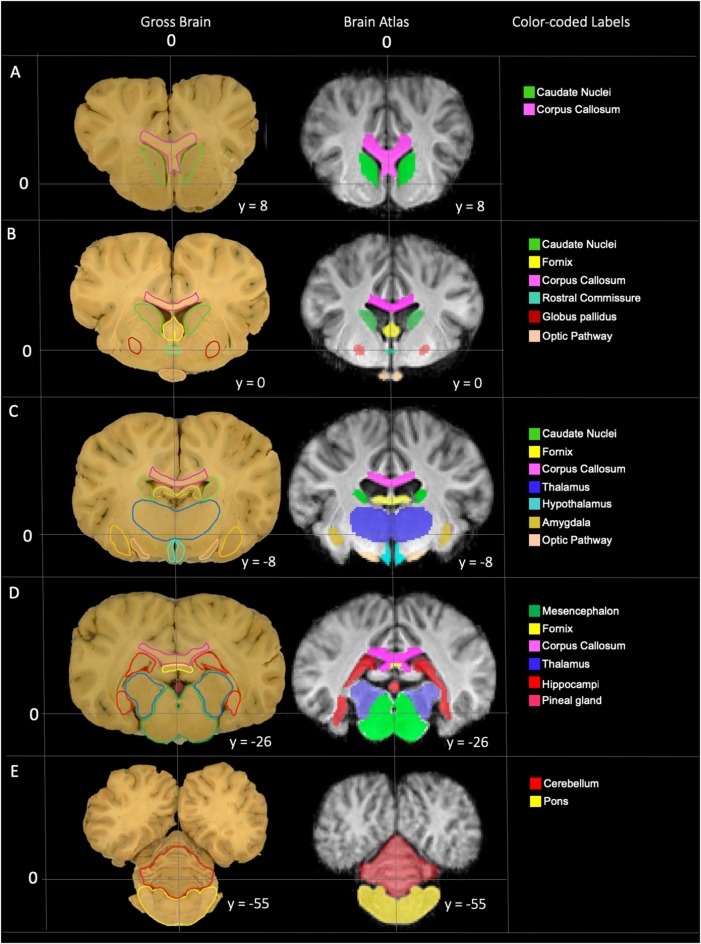
Labeled images demonstrating the manually segmented anatomic priors with correlation to an anatomic specimen. (A) Transverse plane slice at the level of the caudate nuclei (green) demonstrating the rostral aspect of the corpus callosum (pink). (B) Transverse plane slice at the level of the globus pallidus (maroon) including the caudate nuclei (green), corpus callosum (pink), rostral fornix (yellow), rostral thalamus (dark blue), rostral commissure (turquoise) and optic pathway (peach). (C) Transverse plane slice at the level of the inter-thalamic adhesion including the mid corpus callosum (pink), caudal caudate nuclei (green), mid fornix (yellow), mid thalamus (dark blue), hypothalamus (light blue), amygdala (dark yellow) and caudal optic pathway (peach). (D) Transverse plane slice at the level of the hippocampi (red) including the caudal corpus callosum (pink), caudal fornix (yellow), caudal thalamus (dark blue), pineal gland (dark pink), and mesencephalon (dark green). (E) Transverse plane slice at the level of the pons (yellow) including the cerebellum (red).